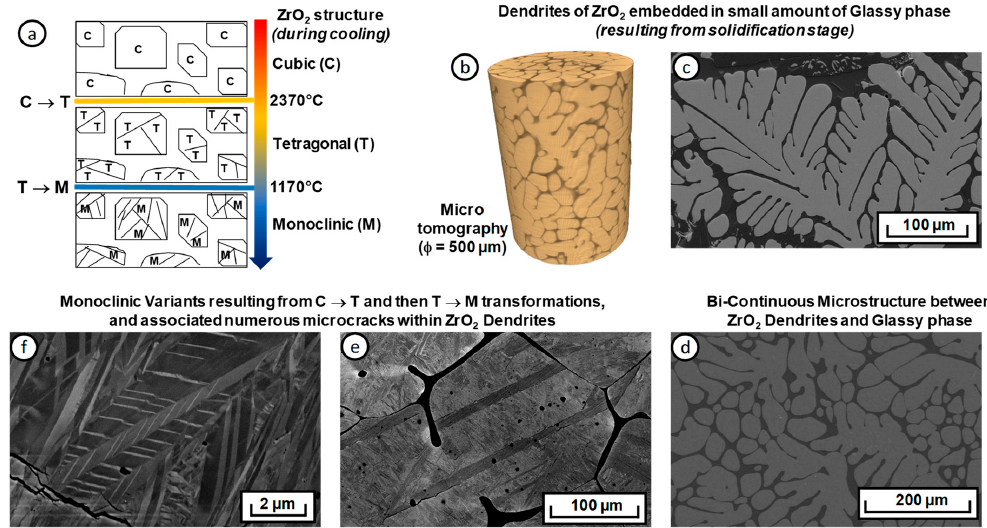
Figure 3. ( a ) Microstructure evolution of the ZrO 2 -SiO 2 refractory; ( b ) 3D microtomography reconstruction of a cylindrical specimen, showing the dendritic structure, as in ( c ) and ( d ) (SEM pictures). ( e ) and ( f ) show the monoclinic variants stemming from the C → T and then T → M phase transformations.